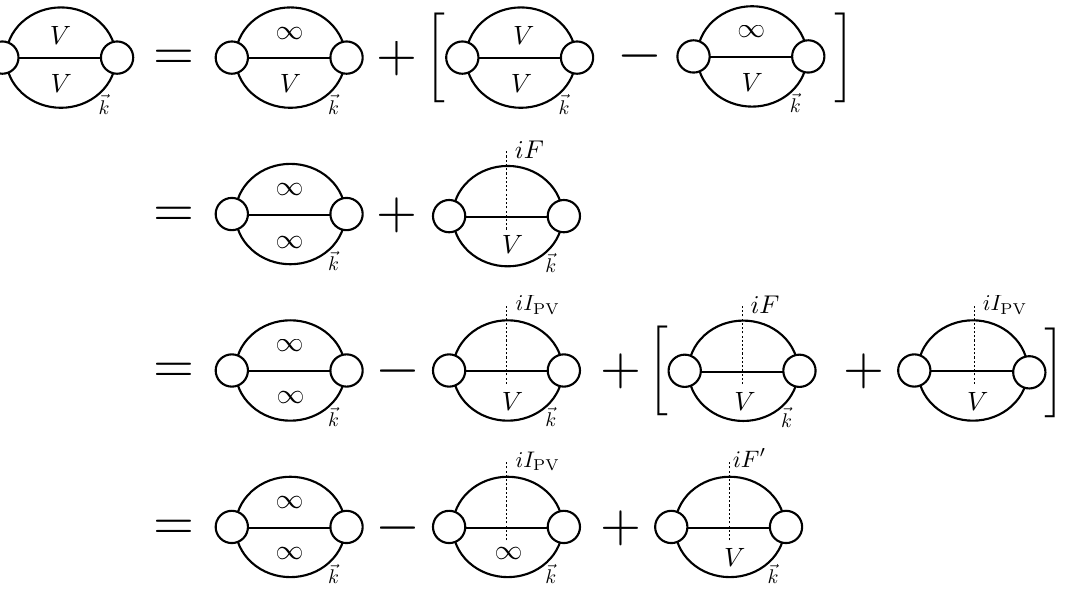
Figure 1 . Illustration of the previous and modi(cid:12)ed PV prescriptions used in the analysis of the three-particle correlation function, for the simplest diagram. Loops containing the symbol \ 1 " are integrated, while those containing a \ V " have the spatial components of the momentum summed. All integrals use the PV prescription. In the (cid:12)rst line the upper sum is replaced by an integral plus a sum-integral di(cid:11)erence. The latter can be replaced by an F cut, as shown in the second line, while the lower loop sum can be replaced by an integral in the (cid:12)rst term on this line. In the third line we subtract and add the I s cut. The (cid:12)nal line shows that this new cut can be absorbed into PV the modi(cid:12)ed F , leaving a modi(cid:12)ed PV prescription for the upper loop